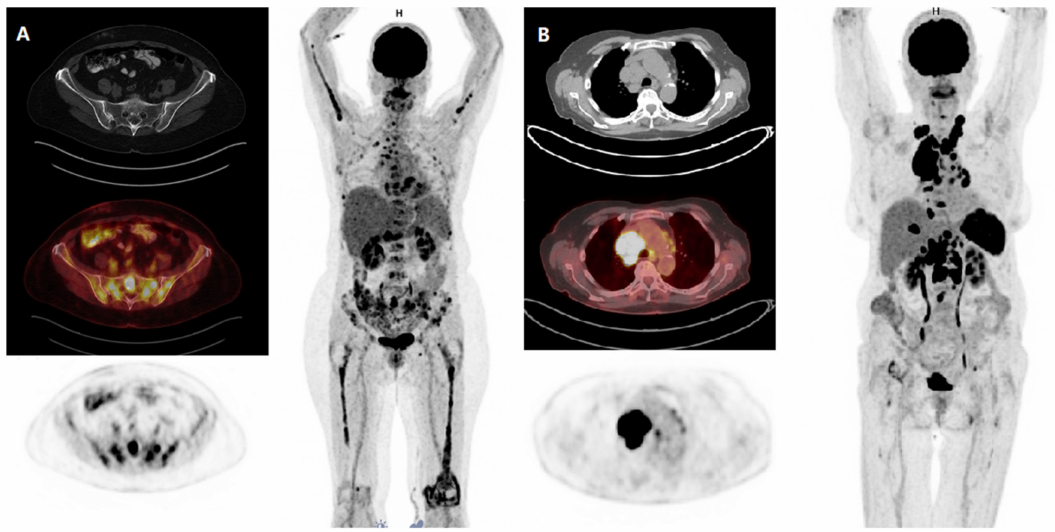
Figure1. 18F-FDGPET / CTintwopatientswithmultiplemyeloma. 18F-FDGPET / CTdemonstratesFDGavid ( A ) medullary lesions (pelvis, spine, both humeri and both femurs) and ( B ) extramedullary manifestations (mediastinal lymph nodes) in patients with multiple myeloma. 18F-FDG, 18F-fluorodeoxyglucose; PET, positron emission tomography; CT, computed